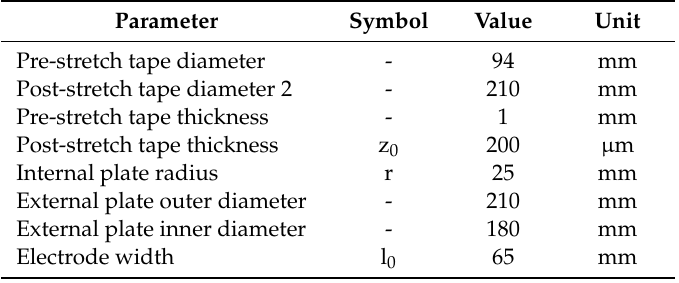
Figure 2. The laboratory kit with dielectric electro active polymer actuator. Table 2. Dimensions of dielectric electroactive polymer actuator.